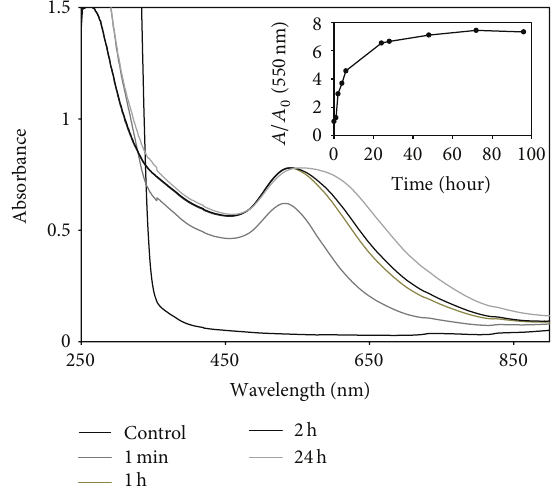
Figure 2: UV-Vis spectra of gold nanoparticles synthesized at different time intervals. Inset shows the absorbance intensity of gold nanoparticles with progressing time ( 𝐴 and 𝐴 0 are absorbance at respective time and ECF only,